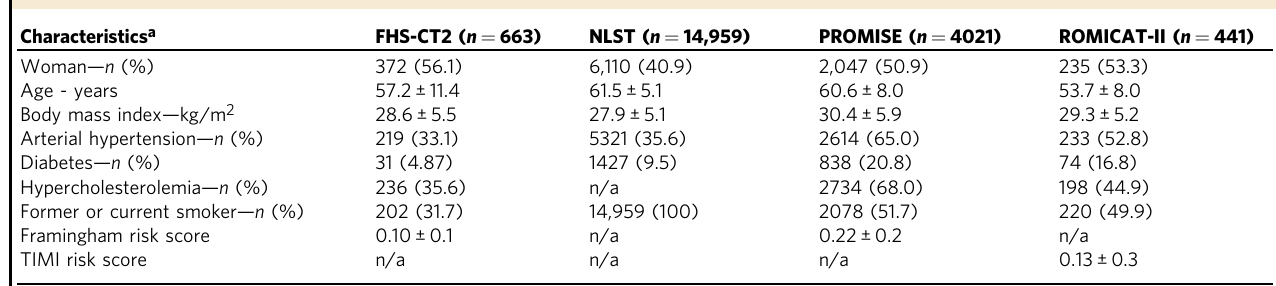
Table 1 Baseline characteristics of subjects in the four test cohorts. Characteristics